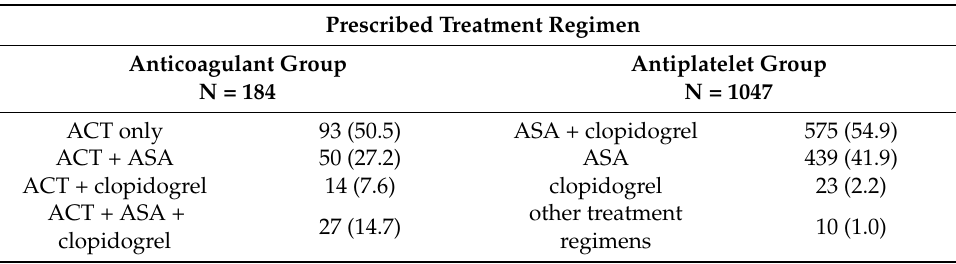
Table 2. Prescribed treatment regimen for the group of patients treated with full-dose anticoagulant therapy and the group of patients treated with antiplatelet therapy.